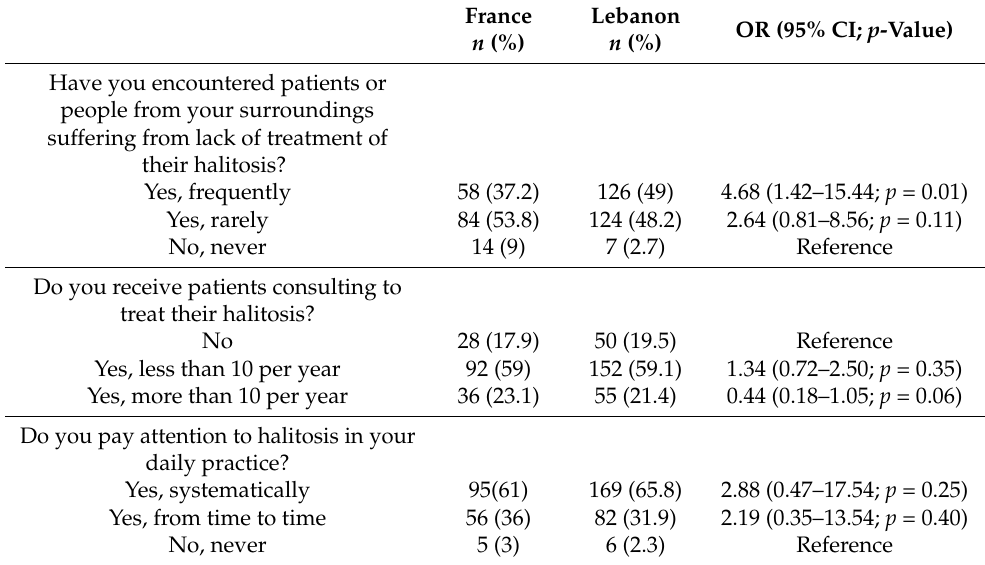
Table 2. Consideration of halitosis during dental consultation. Difference between LD and FD when adjusted for gender, age, and professional experience. A p < 0.05 was considered significant (OR: odds ratio, CI: confidence